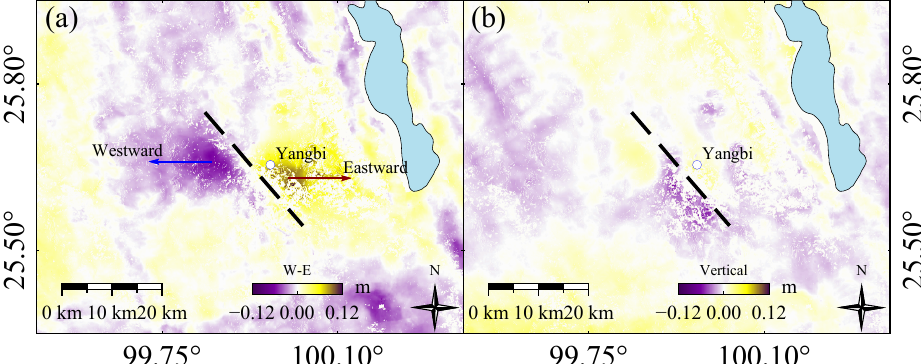
Figure 4. 2.5-D surface deformation ( a ) for the E-W direction and ( b ) for the vertical direction.